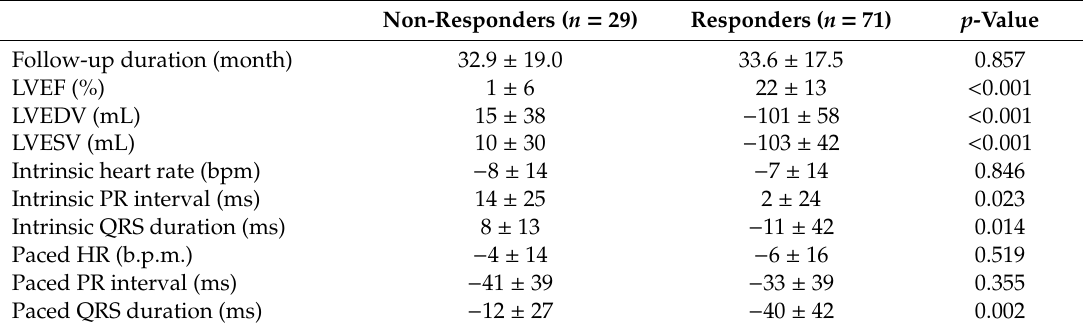
Table 3. Absolute changes in echocardiographic and electrocardiographic parameters according to response status to